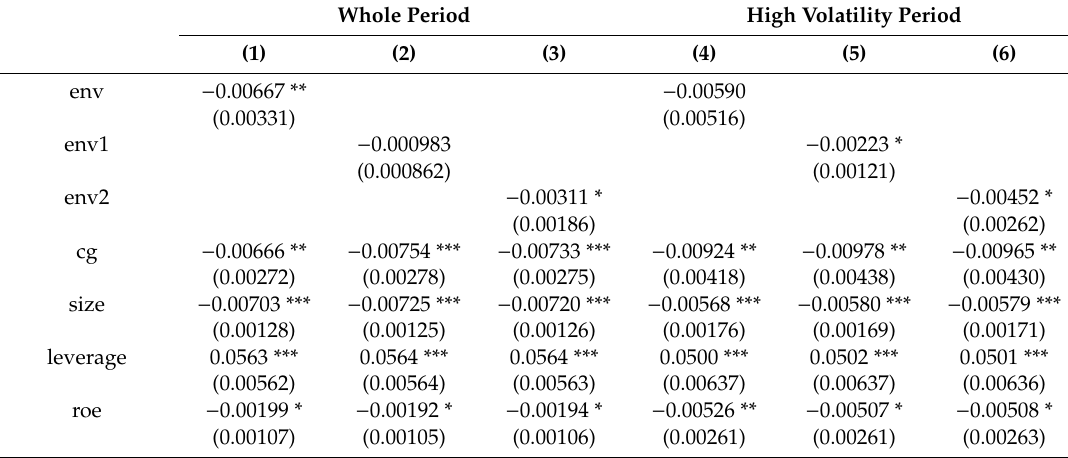
Table 3. Fixed-e ff ect panel